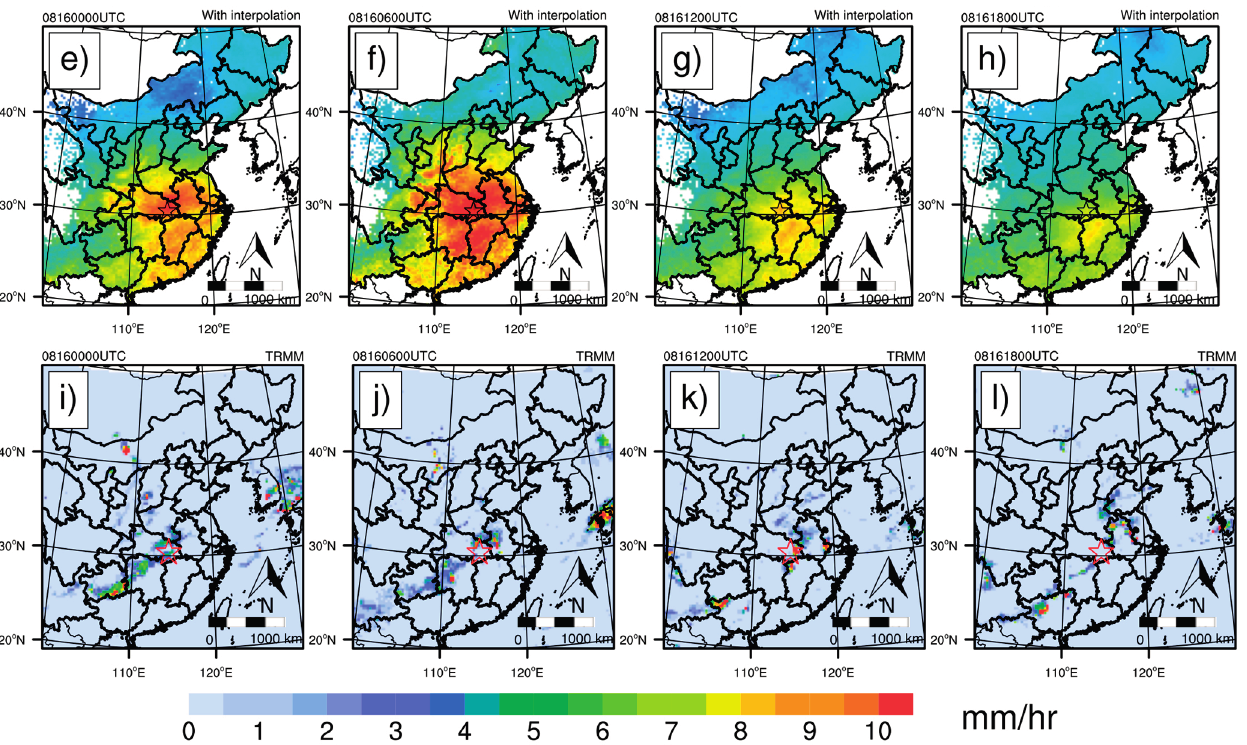
Figure 4. Distribution of PWV and TRMM (Tropical Rainfall Measuring Mission) precipitation over eastern China on 16 August 2008 at 12:00 a.m., 06:00 a.m., 12:00 p.m. and 06:00 p.m. UTC: ( a – d ) original PWV; ( e – h ) reconstructed PWV; ( i – l ) precipitation rate from TRMM data. The location of ‘WHJF’ is marked as star symbol. Missing data or pixels out of the boundary of China are marked in